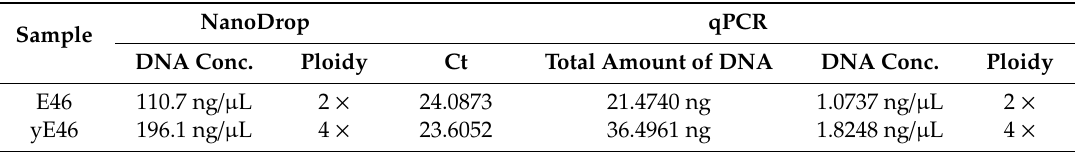
Table 3. DNA concentration measured by NanoDrop and DNA concentration converted by the qPCR method.